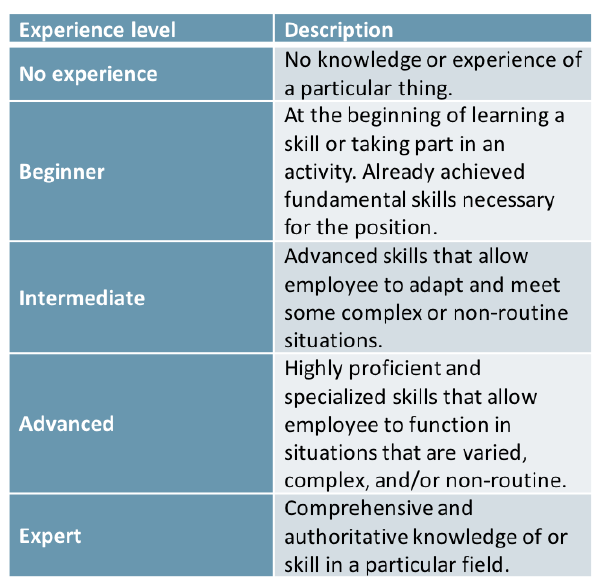
Table 8: Kind of diflculty introduced by different impairments.